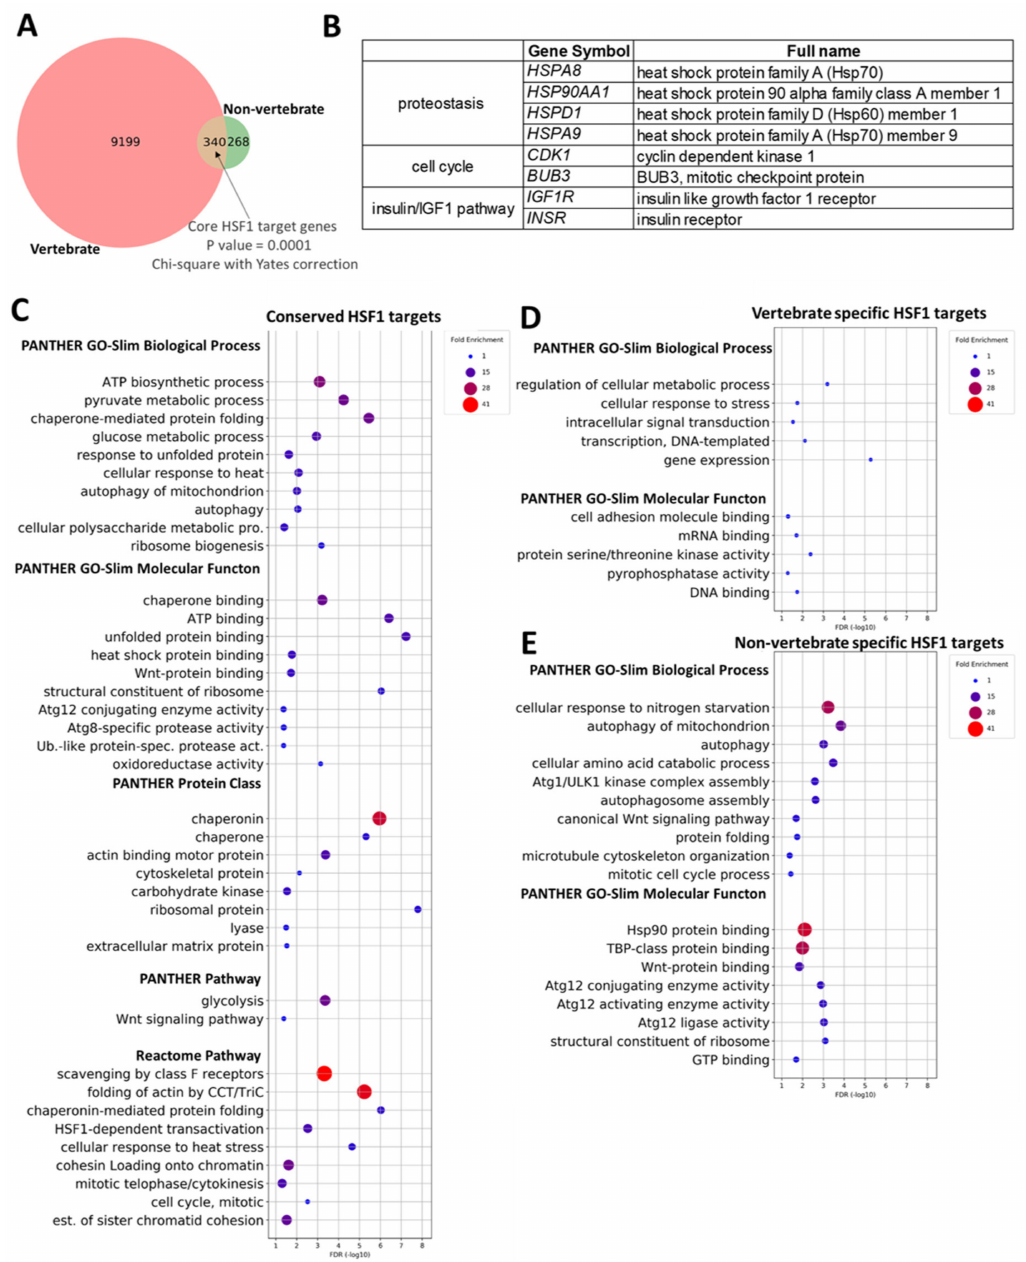
Figure 4. HSF1 targets are conserved between vertebrate and non-vertebrate species. ( A ) Venn-diagram depicting overlaps between HSF1 target genes in vertebrate ( H. sapiens, R. norvegicus, and M. musculus ) and non-vertebrate ( C. elegans, D. melanogaster, and S. cerevisiae ) species, ( p = 0.0001, Chi-square with Yates correction; all unique vertebrate and non-vertebrate orthologues were used as background; 96,072 genes); ( B ) examples of HSF1 targets involved in ageing that are shared among groups vertebrate and non-vertebrate; ( C ) PANTHER GO-Slim Biological Process, PANTHER GO-Slim Molecular Function, PANTHER Protein Class, PANTHER Pathway, and Reactome Pathway analysis of 340 HSF1 target genes conserved between vertebrate and non-vertebrate species; ( D ) PANTHER GO-Slim Biological Process and PANTHER GO-Slim Molecular Function analysis of 9199 vertebrate-specific HSF1 target genes; ( E ) PANTHER GO-Slim Biological Process and PANTHER GO-Slim Molecular Function analysis of 268 non-vertebrate-specific HSF1 target genes. Filled circles depict statistically significant enrichment; X axis shows -LOG10 ( p -value) p < 0.05; Fisher’s exact test with Benjamini–Hochberg False Discovery Rate correction